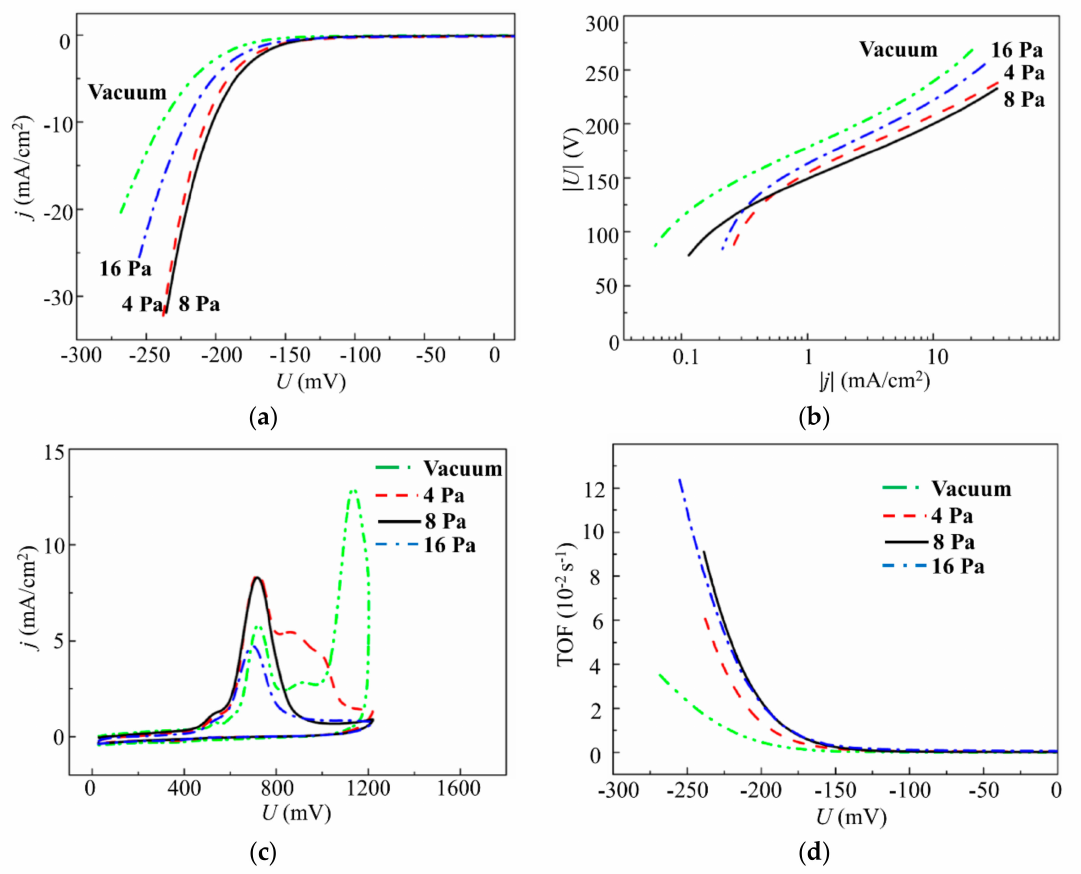
Figure 11. ( a ) Polarization curves. ( b ) Tafel plots. ( c ) Anodic cyclic voltammograms. ( d ) Turnover frequency (TOF) dependence on voltage for the MoS x ~2 + δ / Mo catalysts obtained on GC substrate by on-axis PLD in a vacuum and at di ff erent Ar pressures for 4